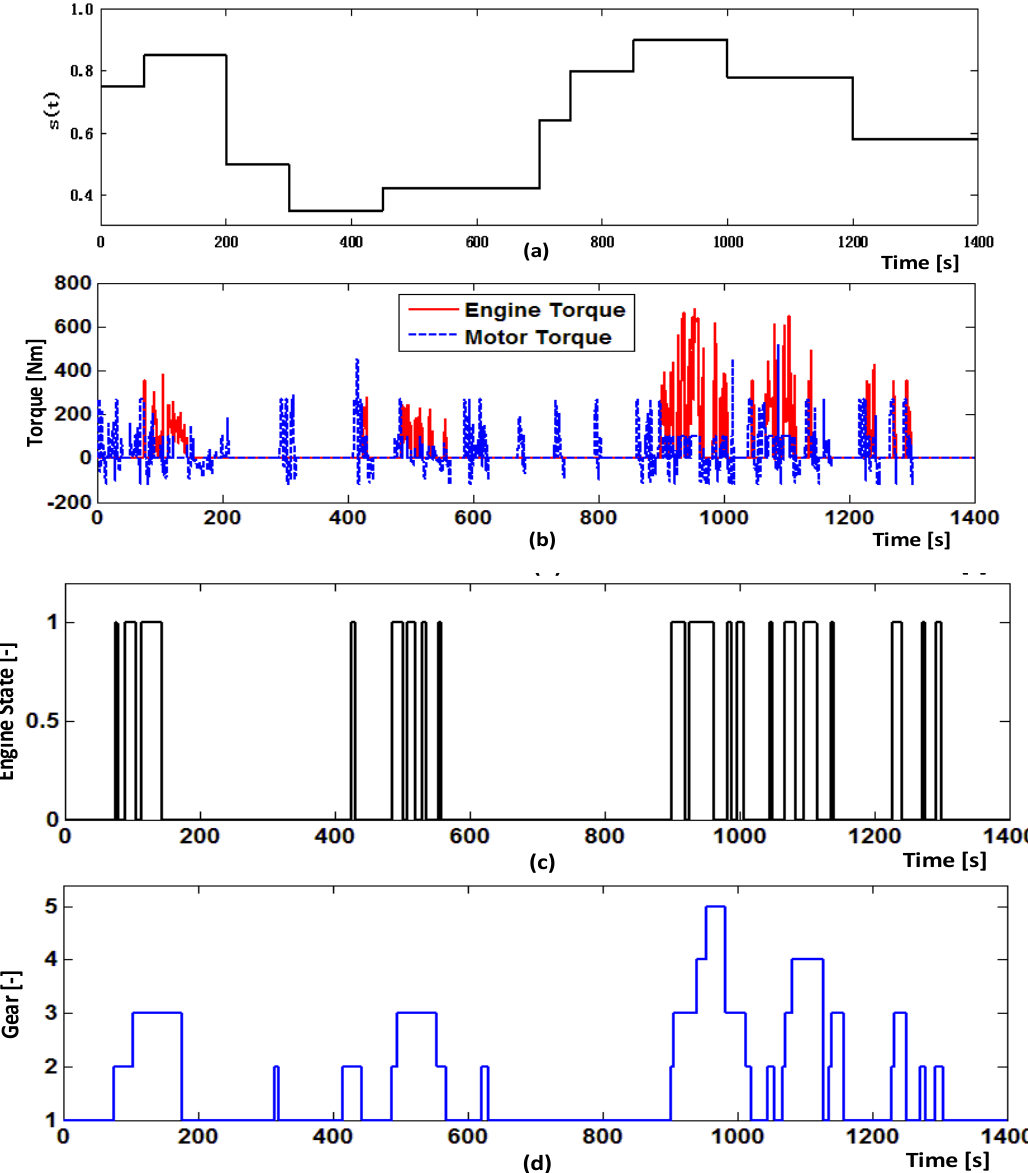
Figure 15. Simulation results for a single driving cycle (2). ( a ) the value of the s ( t ); ( b ) engine torque and motor torque; ( c ) engine state; ( d ) AMT gear position.